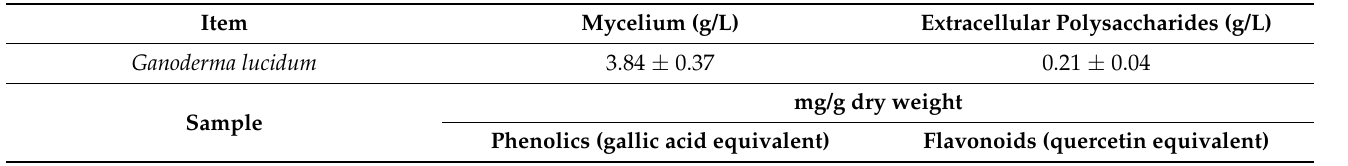
Table 1. Contents of phenolics and flavonoids in the lyophilized powder of submerged culture of Ganoderma lucidum, mycelium, and extracellular